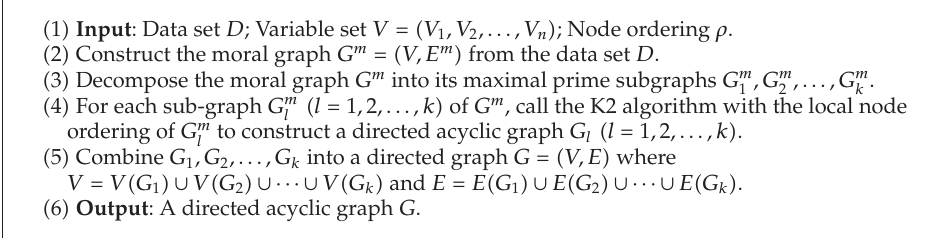
Algorithm 1: Decomposition algorithm for learning